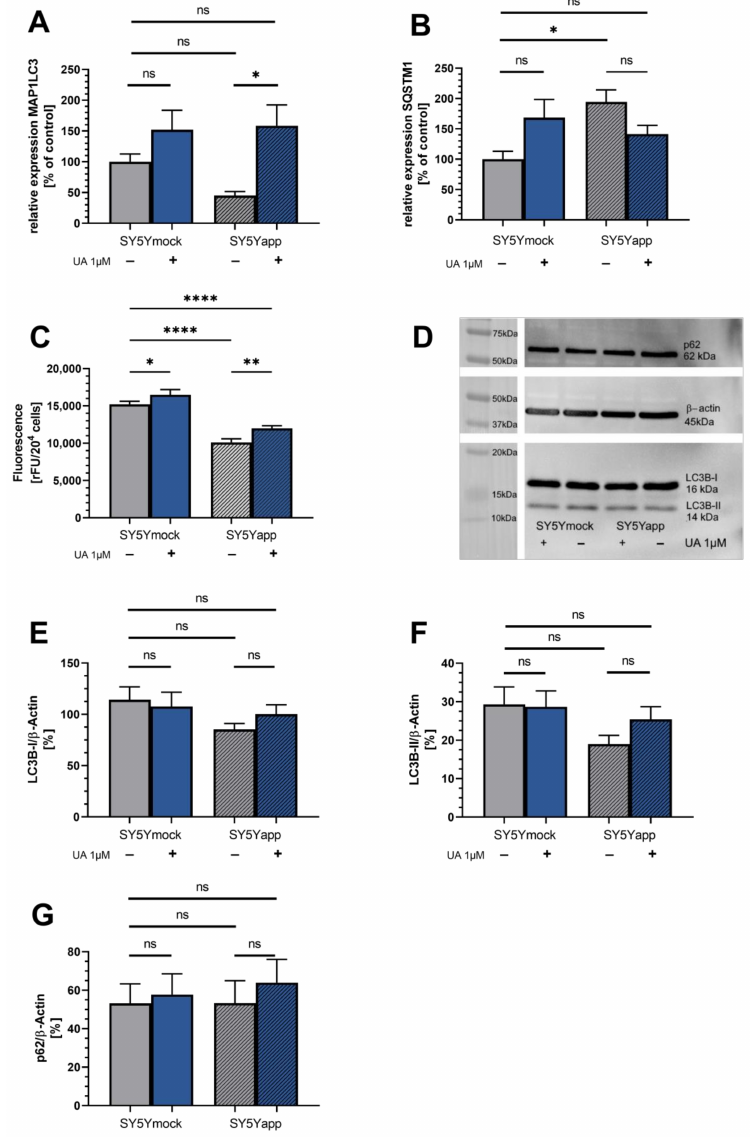
Figure 5. ( A ) Expression of microtubule-associated proteins 1A/1B light chain 3 (MAP1LC3) gene related to autophagy; ( B ) Expression of Sequestosome 1 (SQSTM1) gene related to autophagy. Displayed are data of SY5Ymock (left side) and SY5Y-APP695 cells (right side) which were measured separately from each other. Data of both cell lines is adjusted to SY5Ymock ctrl group = 100%; N = 8–10; Displayed are means ± SEM. Results were normalized to the mRNA expression levels of three housekeeping genes (beta-actine (ACT β ), Glyceraldehyde 3-phosphate dehydrogenase (GAPDH) and Phosphoglycerate Kinase 1 (PGK1)) according to the MIQE guidelines. ( C ) Fluorescence of marker dye binding to au- tophagosomes of SY5Ymock and SY5Y-APP695 cells. Displayed are means ± SEM. N = 10. ( D ) Western blots of LC3B-I, LC3B-II, and p62 in SY5Ymock and SY5Y-APP695 treated with 1 µ M UA or ctrl. β -Actine was used for housekeeping and results have been adjusted to it (Figure 2E–G). Gels were loaded with 15 µ g protein. ( E , F ) Western blot results from LC3B-I and LC3B-II adjusted to β -actine. Displayed are means ± SEM. N = 9. ( G ) Western blot results from p62 adjusted to β -actine. Displayed are means ± SEM. N = 8. Cells were incubated with either 1 µ M UA or its DMSO control (ctrl). Statistical significance was tested via two-way ANOVA followed by a false discovery rate correction according to Benjamini, Krieger, and Yekutieli. Significance is displayed as: ns p > 0.05, * p < 0.05, ** p < 0.01 and **** p < 0.0001. List of all statistical parameters and comparisons can be found in Supplementary Table